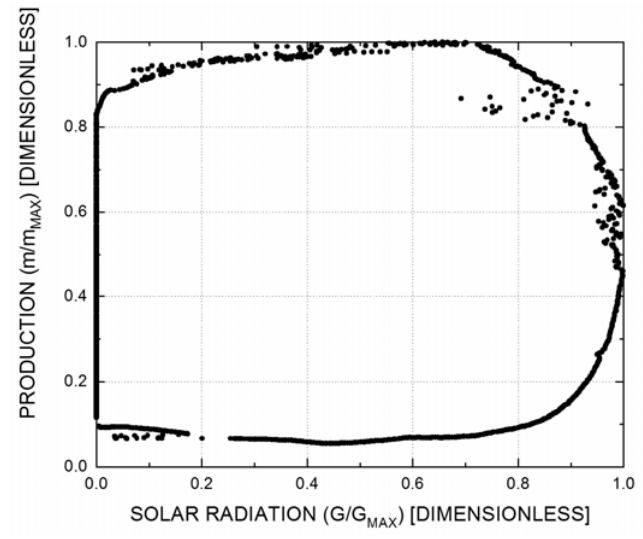
Figure 15. Thermal inertia characteristic of large solar stills.